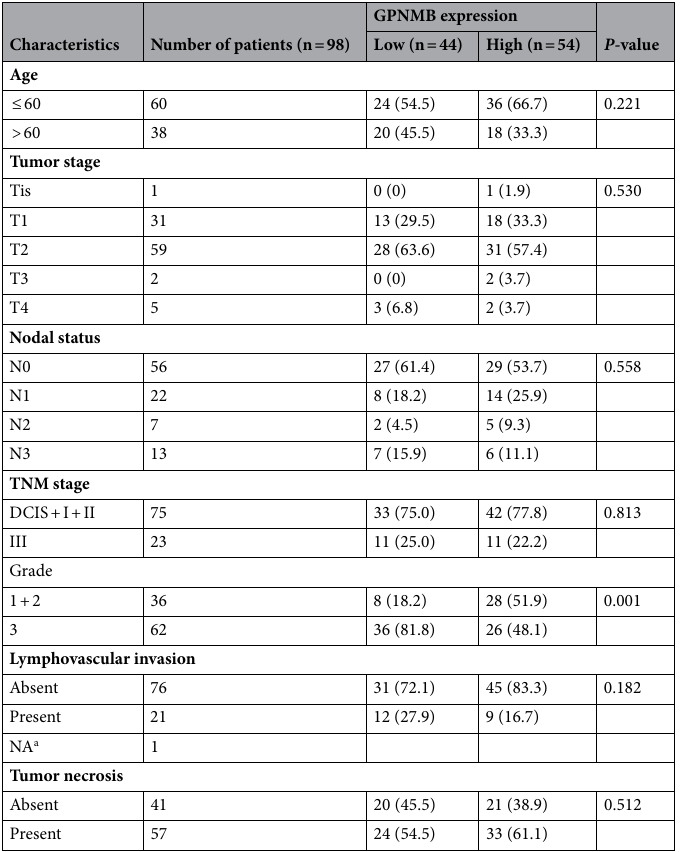
Table 2. Association of clinical and pathological characteristics with GPNMB expression in 98 patients with TNBC. a NA, not available.